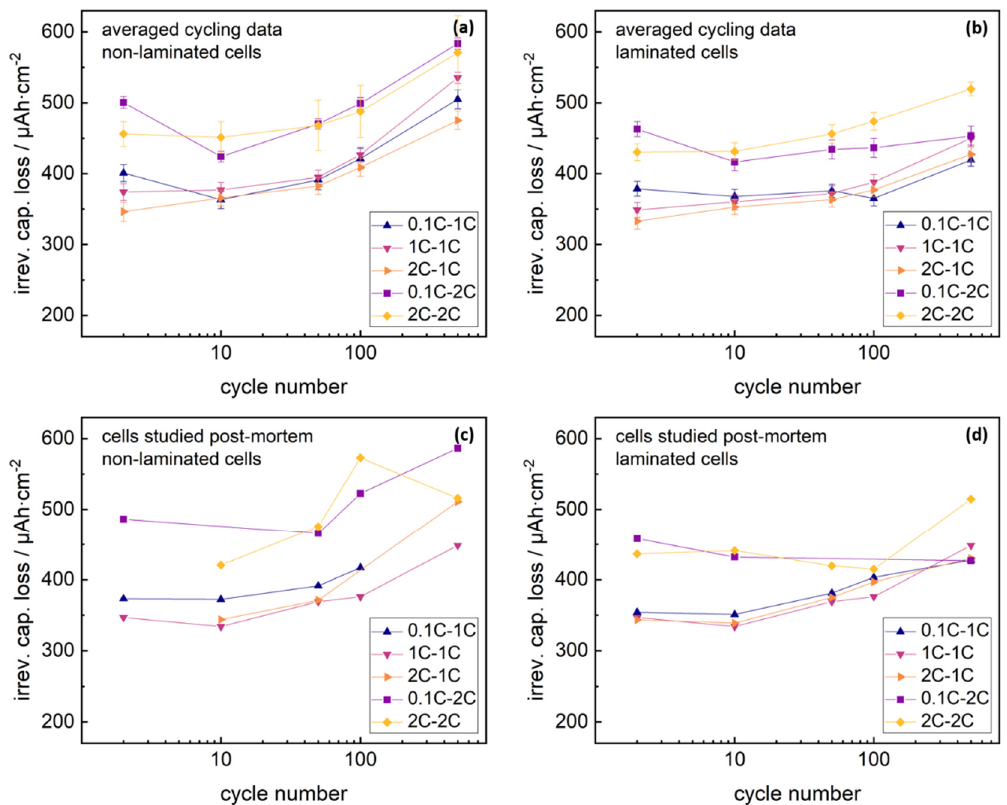
Figure 3. Active lithium loss of non-laminated / laminated cells calculated from capacity-fade in cycling test; data at 2 cycles corrected with C-rate corrective term; ( a , b ) active lithium loss from non-laminated / laminated cells given by average cycling test data, error bars indicated; ( c , d ) active lithium loss from non-laminated / laminated cells given by exemplary cycling test data from cells studied post-mortem with neutron depth profiling (NDP).